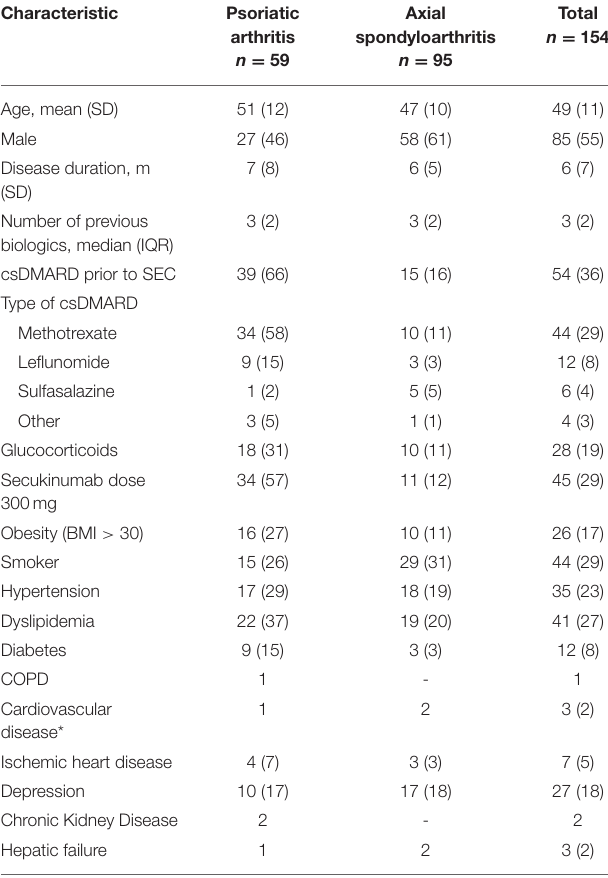
TABLE 1 | Disease characteristics of the study